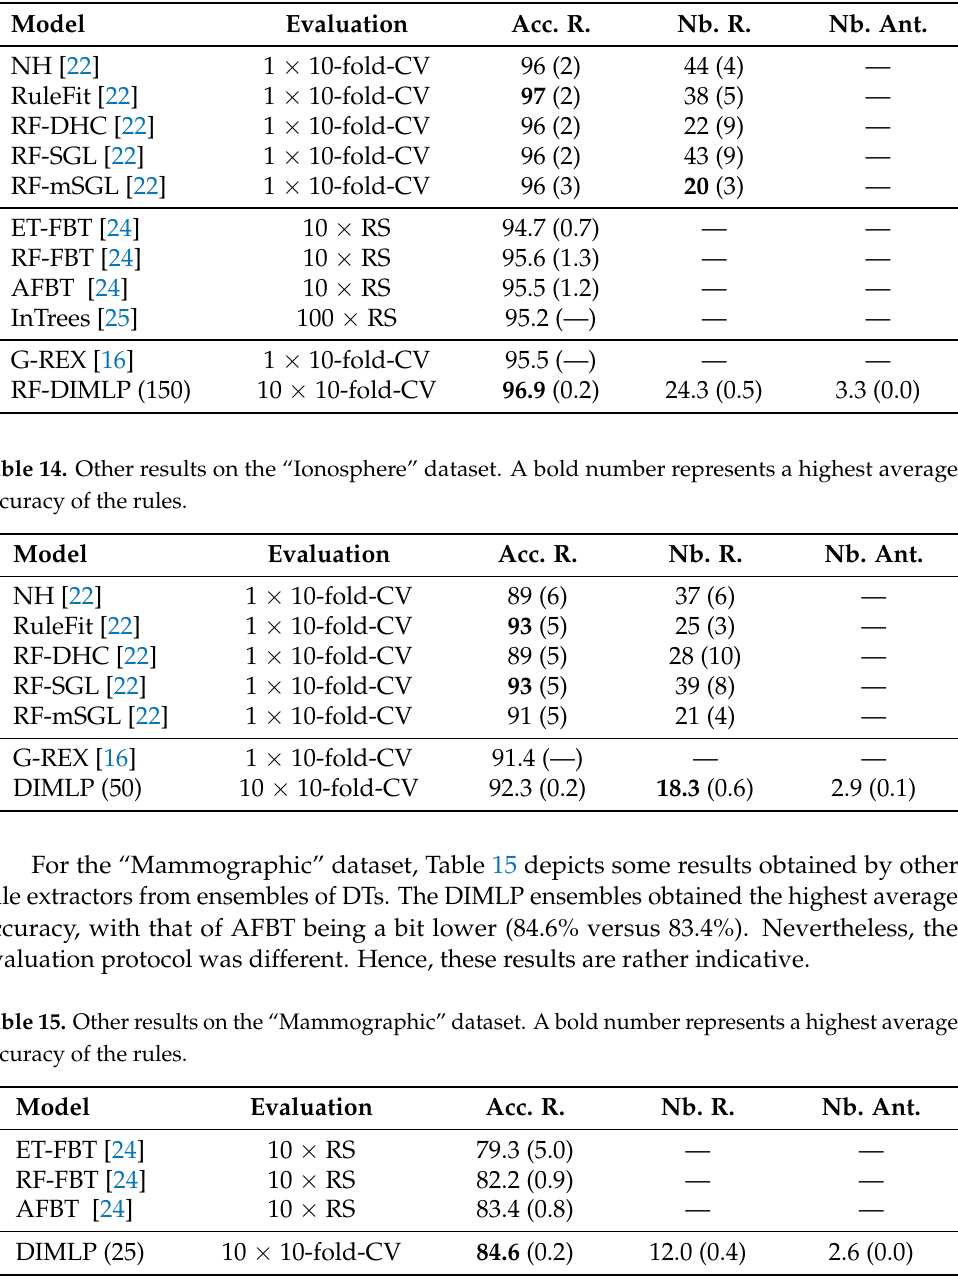
Table 13. Other results on the “Breast Cancer” dataset. A bold number represents a highest average accuracy of the rules.